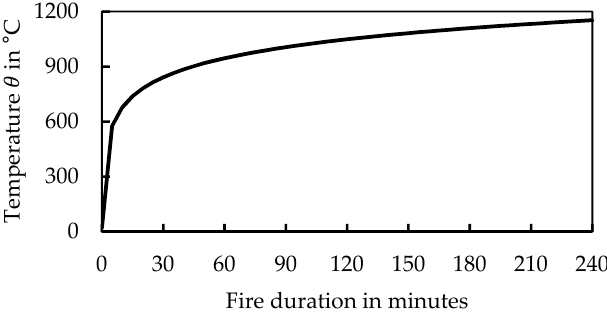
Figure 1. Unit—temperature—time curve (reproduced from [8]). Figure 1. Unit ‒ temperature ‒ time curve (reproduced from [8]).